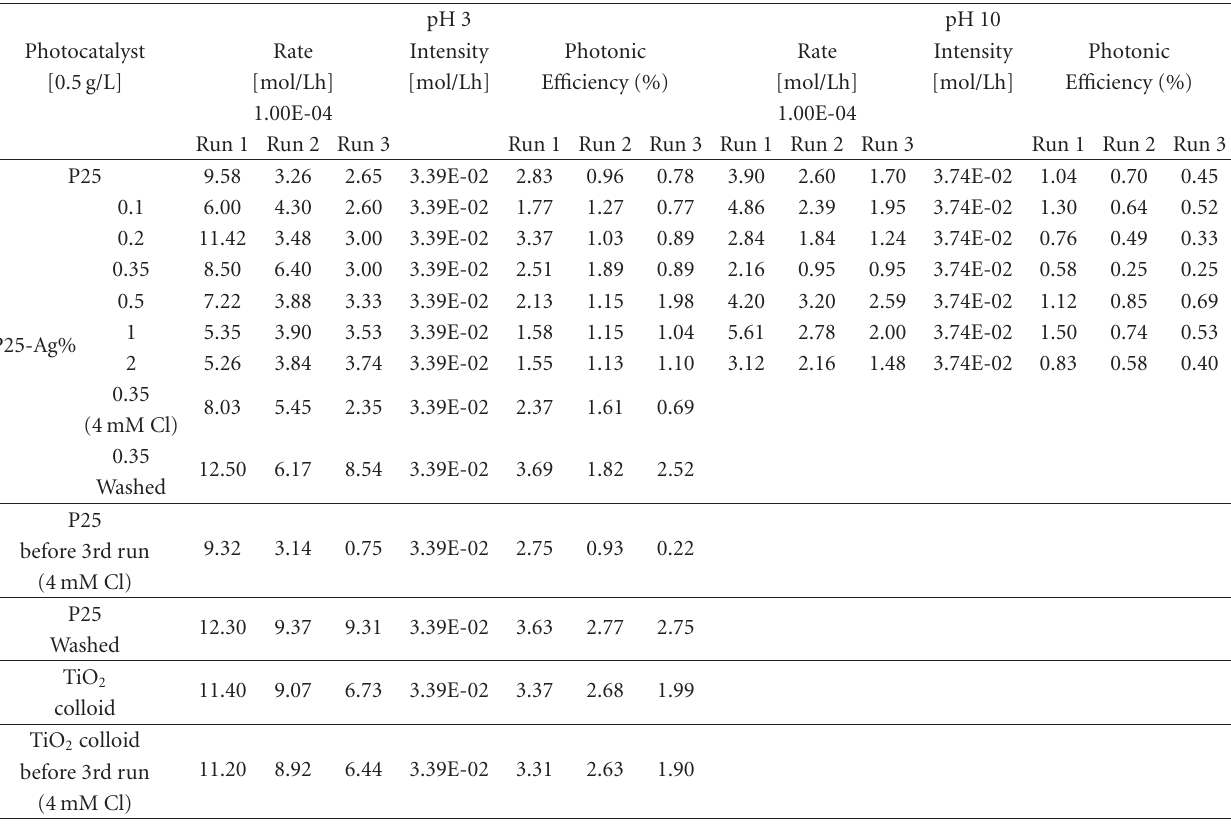
Table 1: Photonic e ffi ciency values of the employed photocatalysts (e.g., as given in Figures 2 and 3). pH 3 pH 10